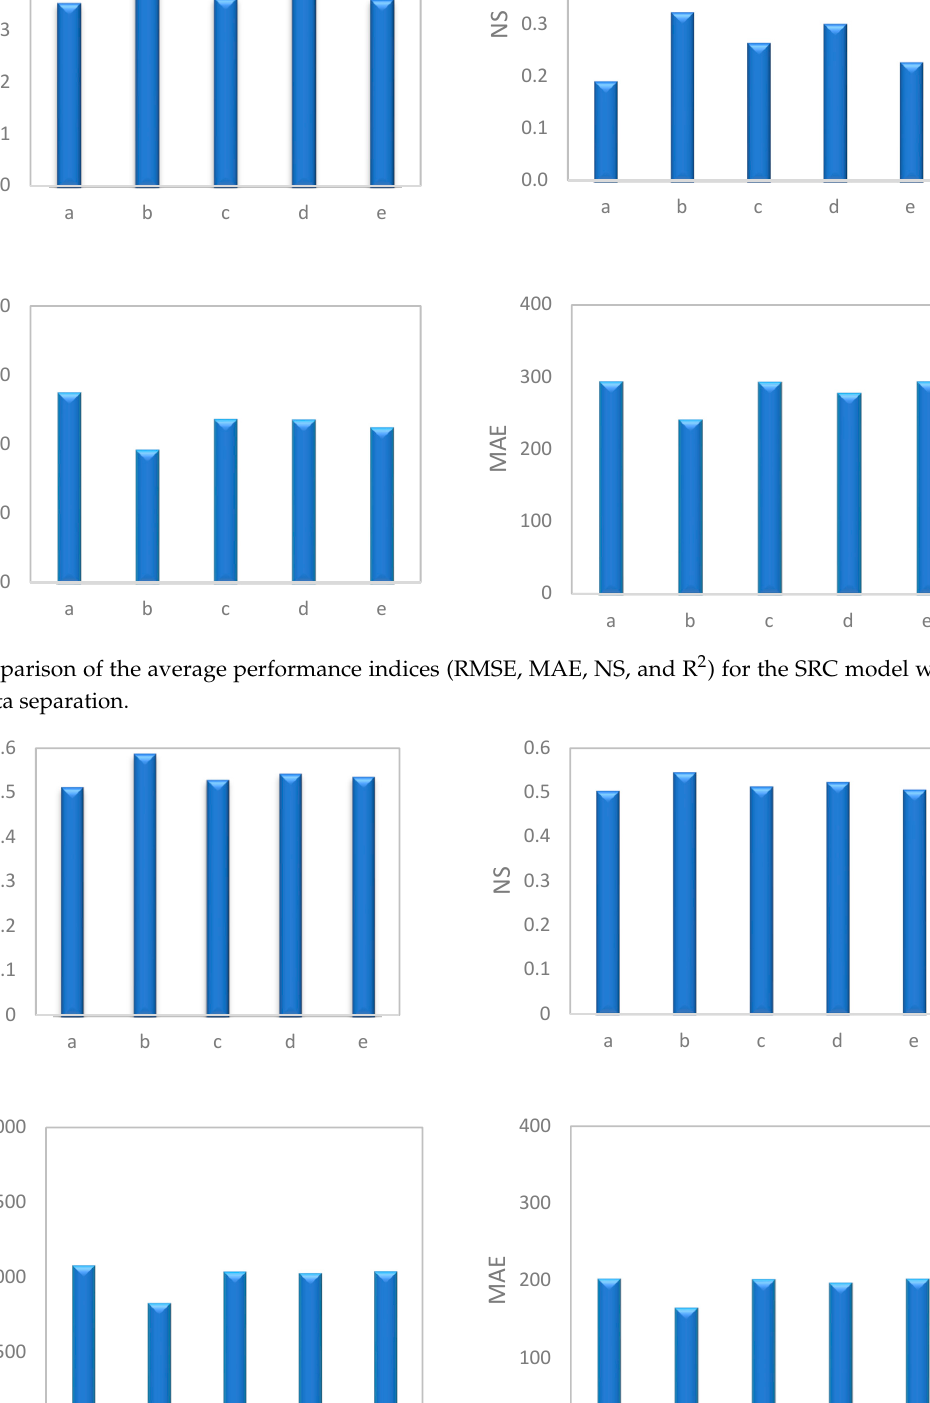
Figure 5. Comparison of the average performance indices (RMSE, MAE, NS, and R 2 ) for the SVR model with different methods of data separation. 4.5. The Most Effective Model for Estimating SSC Based on our findings and comparing performance indices (Figures 4 and 5 and Ta- bles 5, 6 and 8), the seasonal SVR model has the highest estimation power (RMSE = 819.91 mg/L, MAE = 163.58 mg/L, NS = 0.54 and R 2 = 0.59) followed in order by high water/low water period SVR (NS = 0.52), discharge classes SVR (NS = 0.51), hydrograph state SVR (NS = 0.50), SVR (NS = 0.50), SRC-PSO (NS = 0.44), SRC-GA (NS = 0.41), SRC-ICA (NS = 0.40), seasonal SRC (NS = 0.32), high water/low water period SCR (NS = 0.30), SRC-CF2 (NS = 0.29), discharge classes SRC (NS = 0.26), SRC-FAO (NS = 0.25), hydrograph state SCR (NS = 0.23) and SRC (NS = 0.19). Overall, our findings show that the SVR model presented better results in all cases with lower error values and higher NS and R 2 than the SRC, including its optimized ver- sions. In general, according to our results, the SVR model can be used to estimate SSC in